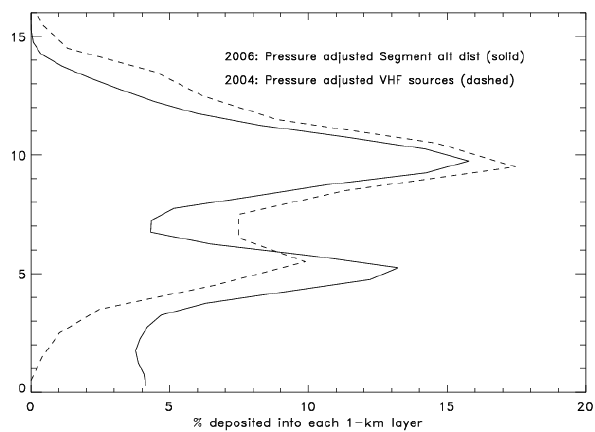
Figure 1. Vertical distribution of lightning-NO production assumed for 2004 (dashed) and Fig. 1. Vertical distribution of lightning-NO production assumed 2006 (solid) simulations. The distribution for 2004 was derived from the vertical for 2004 (dashed) and 2006 (solid) simulations. The distribution distribution of VHF sources in the vicinity of the Northern Alabama LMA during the April to September 2003-2005 time period. The distribution for 2006 was derived from for 2004 was derived from the vertical distribution of VHF sources the vertical distribution of segment altitude distributions in the same area. in the vicinity of the Northern Alabama LMA during the April to September 2003–2005 time period. The distribution for 2006 was derived from the vertical distribution of segment altitude distribu- tions in the same